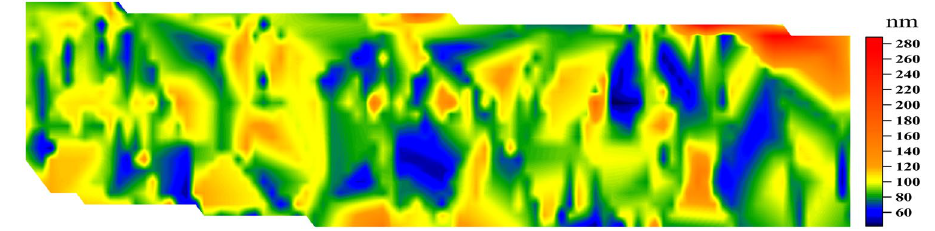
Figure 6. Magnified image of GNP size distribution on liver 8 h after intravenous